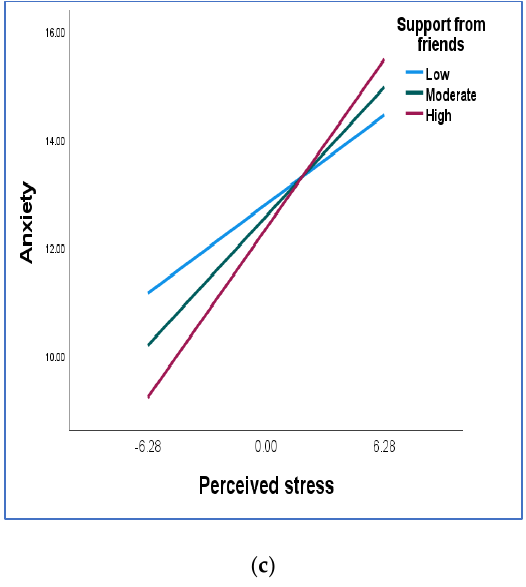
Figure 2. Illustration of the moderating role of the dimensions of social support in the relationship between perceived stress and anxiety: ( a ) the role of support from significant others; ( b ) the role of support from family; ( c ) the role of support from friends.